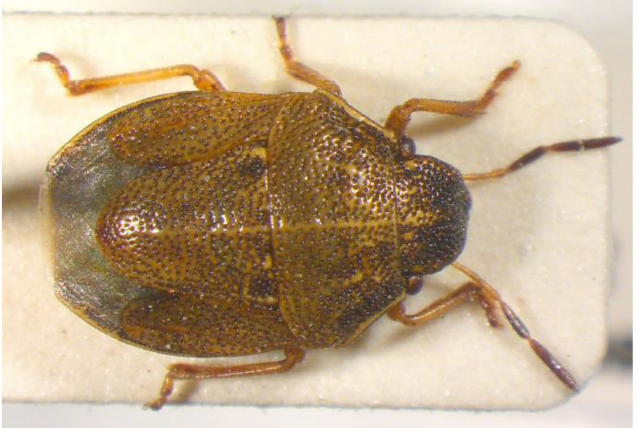
Figure 12. Neottiglossa pusilla (Collector S. Drosopoulos, Vathyrhemma, 26.VII.1982, posited in S. Drosopoulos historical collection. Photo A. Tsagkarakis,